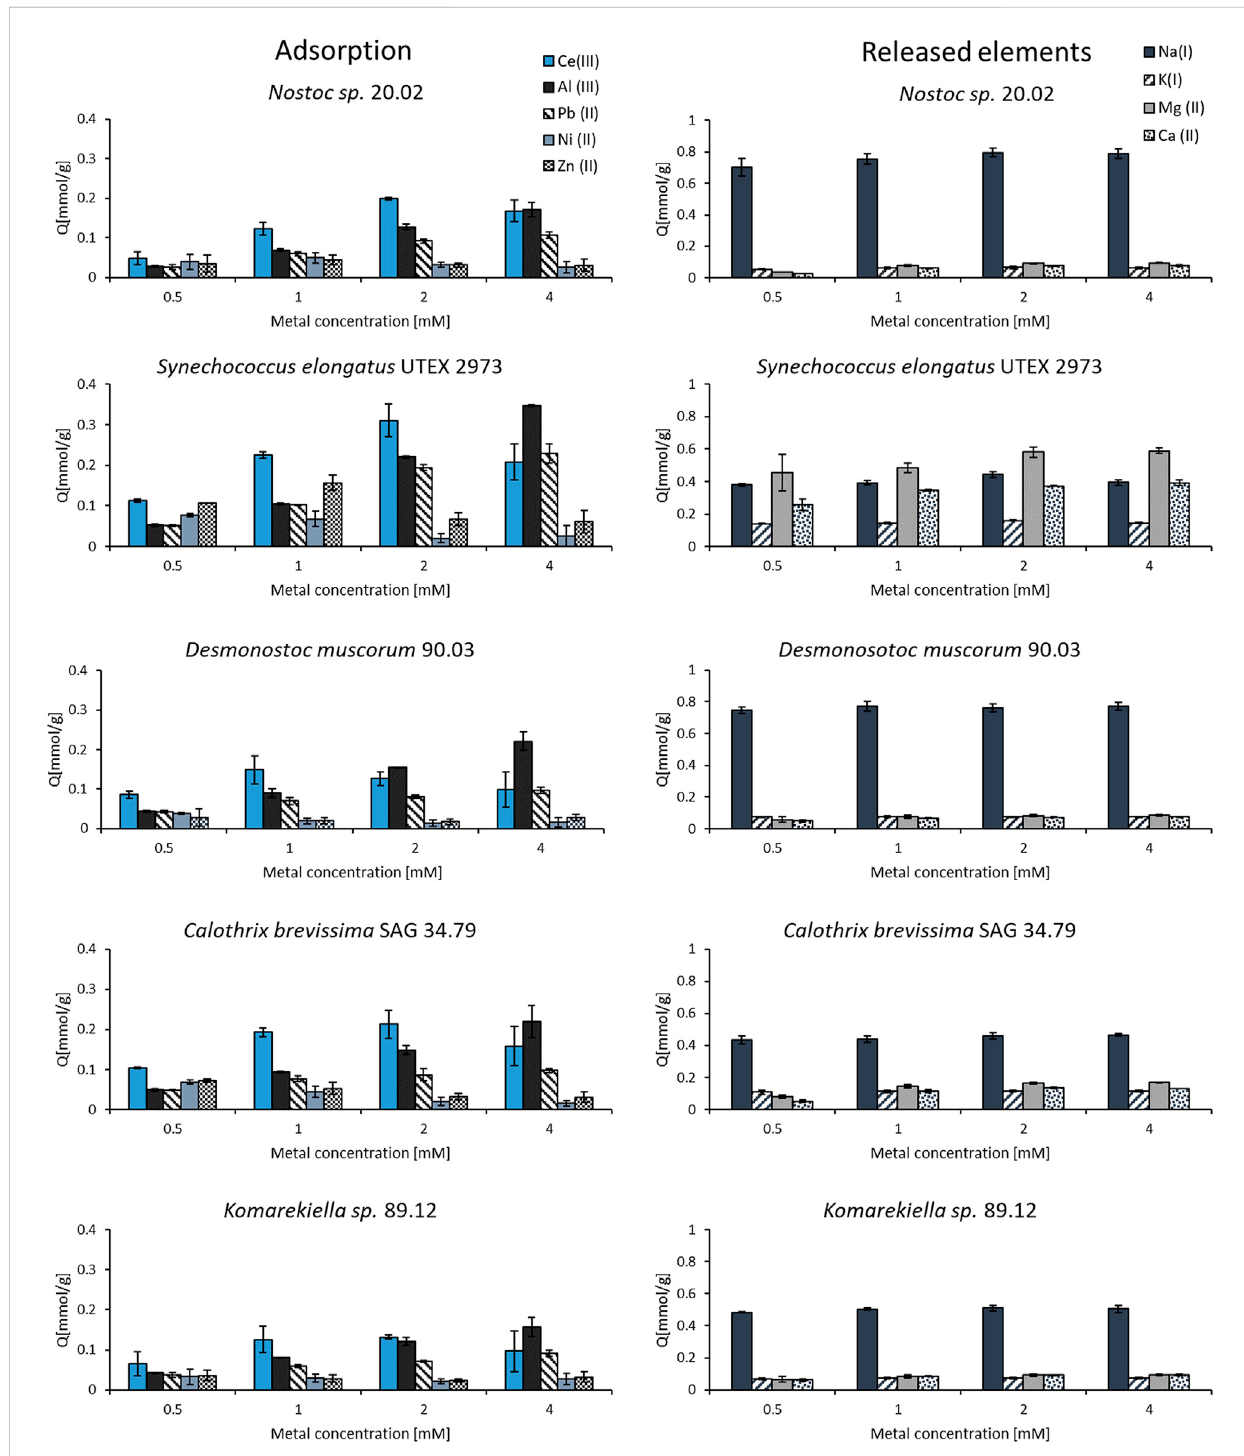
FIGURE 6 Adsorption and release of elements from biomass incubated in equimolar mixed-metal (Ce, Al, Pb, Ni, and Zn) solutions with concentrations between 0.5 – 4.0 mM (n = 3).